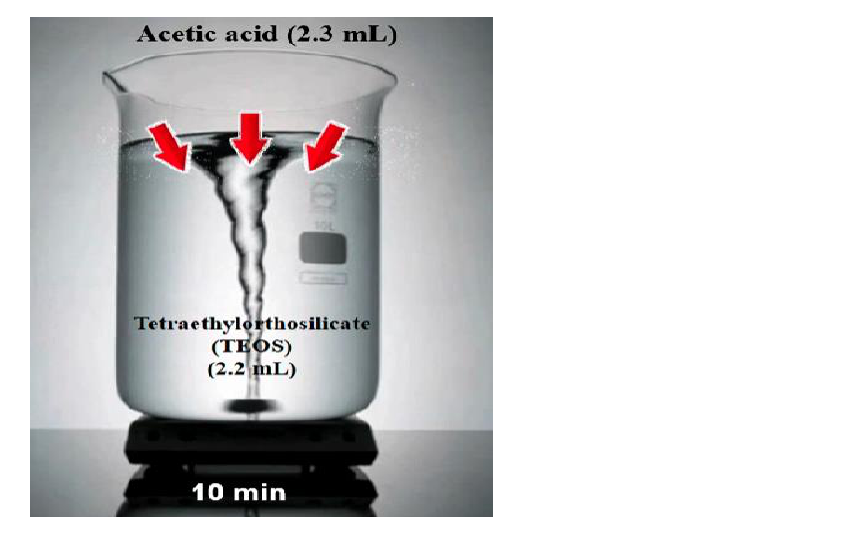
Figure 3. Adding 2.3 mL acetic acid to 2.2 mL Tetraethlorthosilicate (TEOS) and stirring for 10 min.